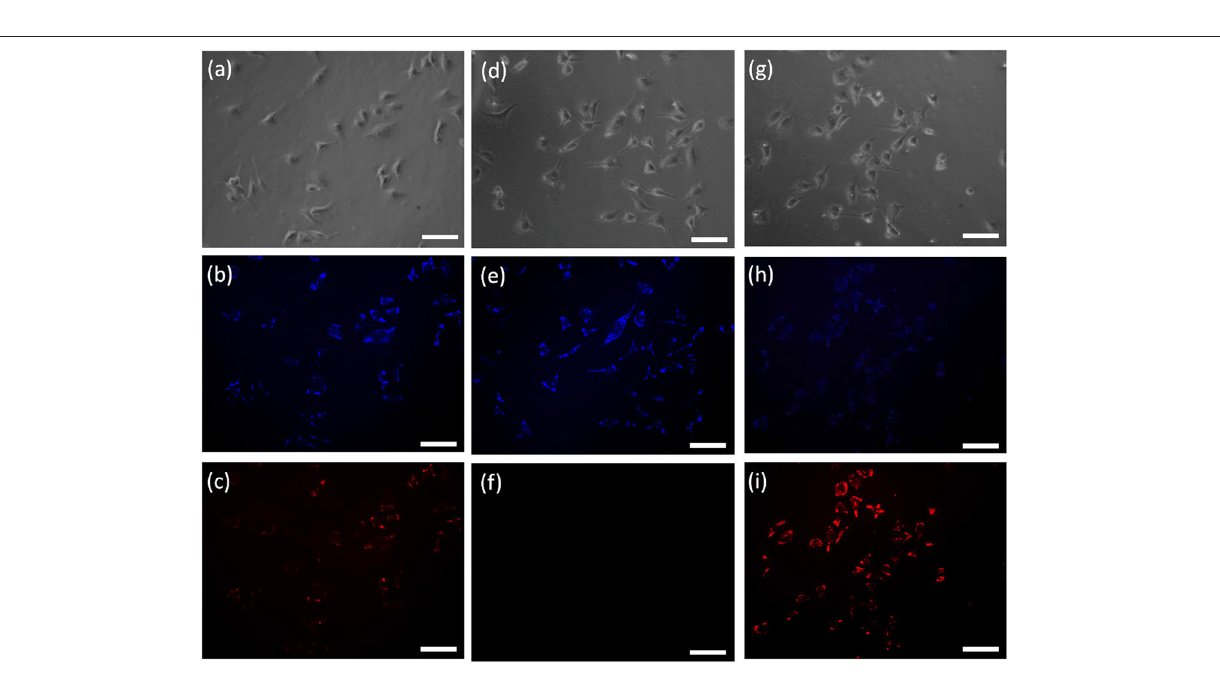
FIGURE 5 | Confocal fluorescence images of living Hela cells incubated with the probe HBT-Cys (20 µ M) for 120min at 37 ◦ C: cells without treatment (a–c) , cells with pre-treatment of NEM (1mM) (d–f) , and cells with pre-treatment of NEM (1mM) and further addition of 200 µ M Cys (g–i) . (a,d,g) are the bright-field images; (b,c,e,f,h,i) are the fluorescence images at blue and red channels, respectively. The scale bar represented 100 µ